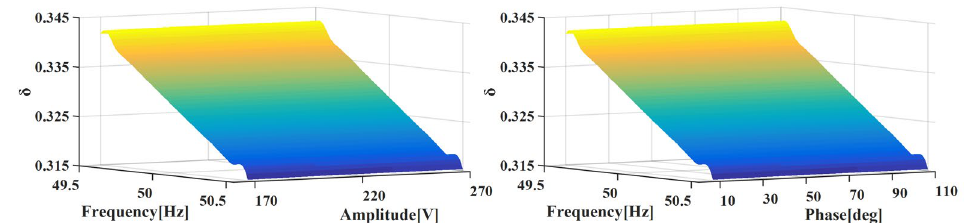
Figure 3. The relation between the spectral interference rate and phasor. (1) DC component: As is well known, the frequency of a power grid signal fluctuates within a certain range, and the spectral interference rate changes with the frequency fluctuation. As such, the apDFT is carried out for a group of single-tone power grid signals with different frequencies, and the corresponding group of spectral interference rates δ r and δ i are calculated. The expression of the relation between the spectral interference rate and the frequency of the power grid can be obtained by fitting this curve: